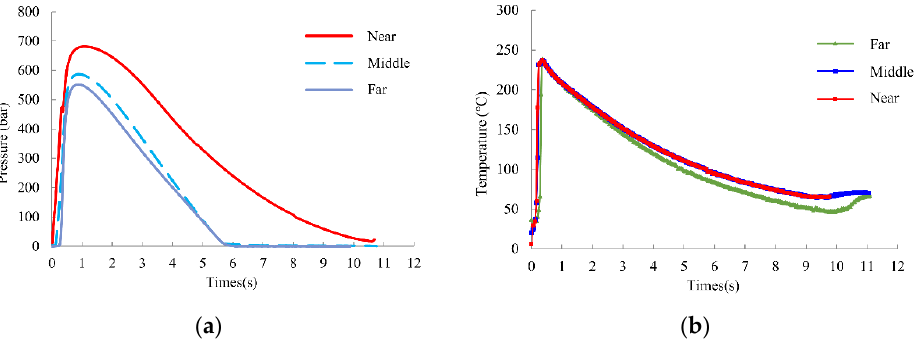
Figure 5. Three sections of ( a ) practical processing pressure curves and ( b ) real melted temperature curves.